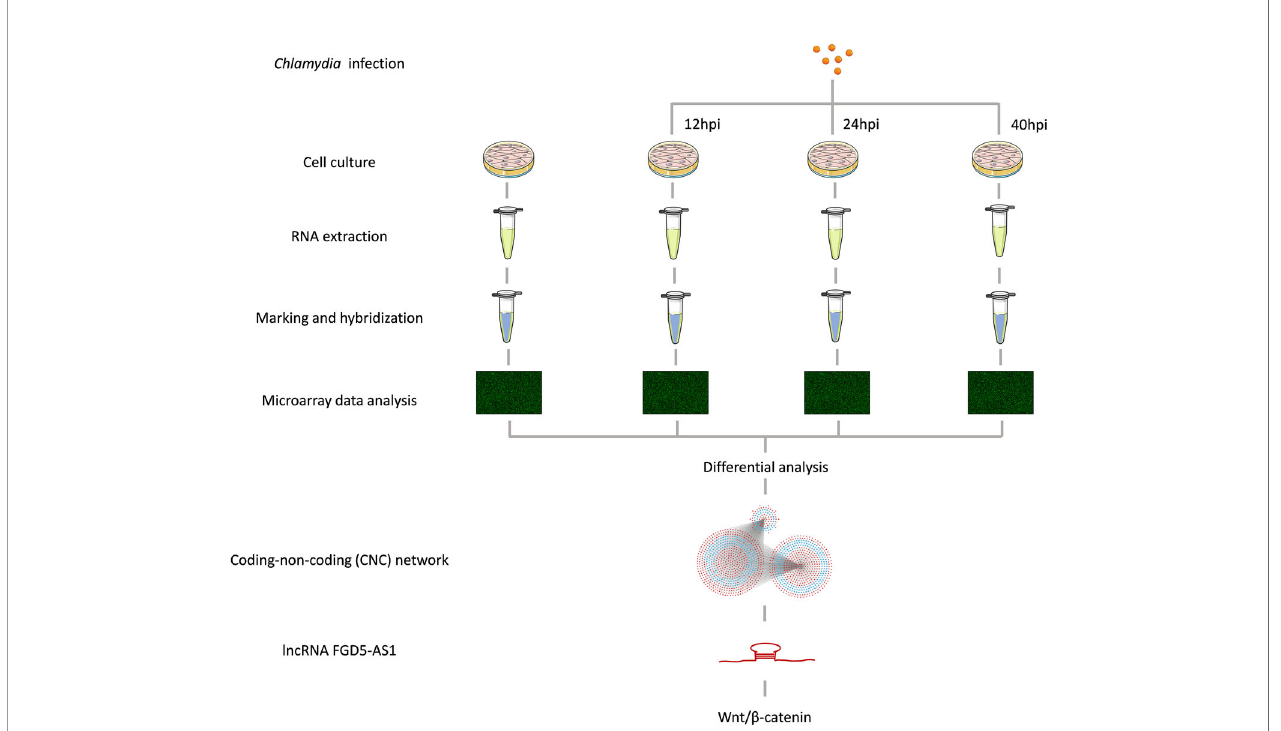
FIGURE 1 | The schematic fl ow of the experiment. Part of elements come from SMART